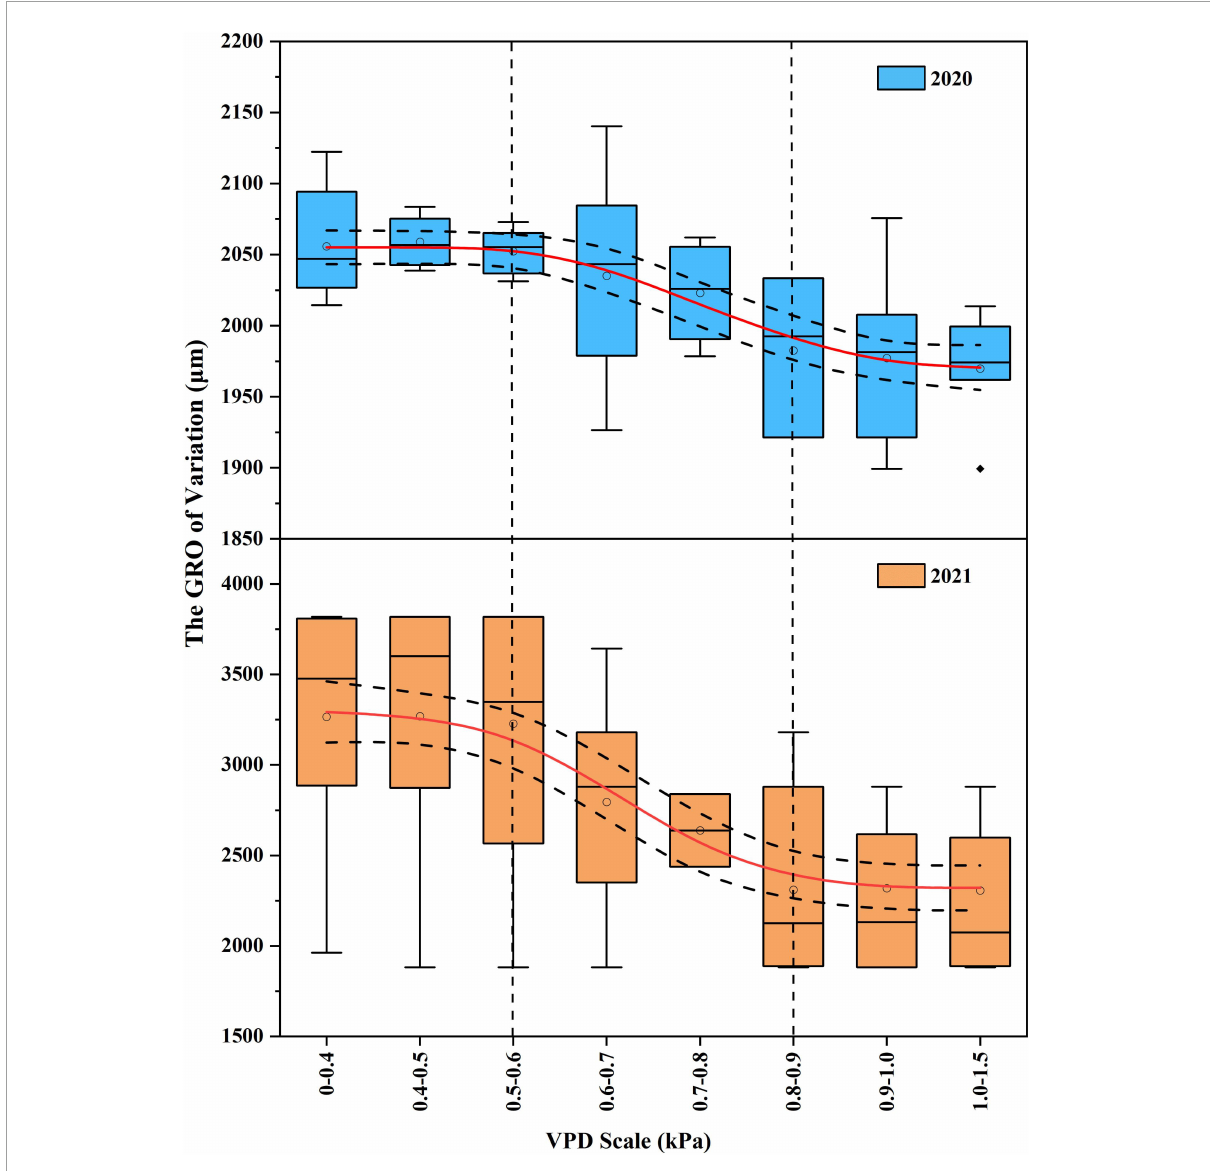
FIGURE8 The boxplot of the GRO variation of trees for different VPD threshold ranges in 2020 and 2021. The stem radial growth decreases with increasing VPD. The dashed part is the confidence interval obtained with the Logistic models.